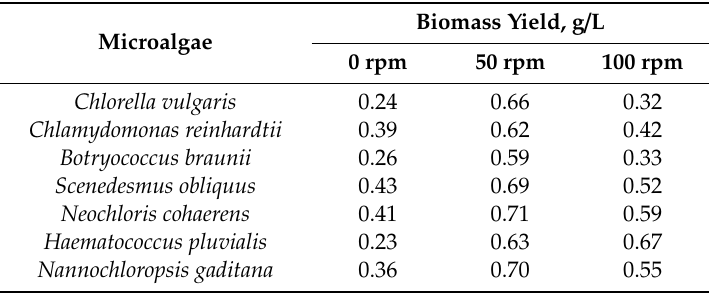
Table 3. The influence of culture stirring on the growth of various microalgae (table reconstructed using data from Varshney et al.